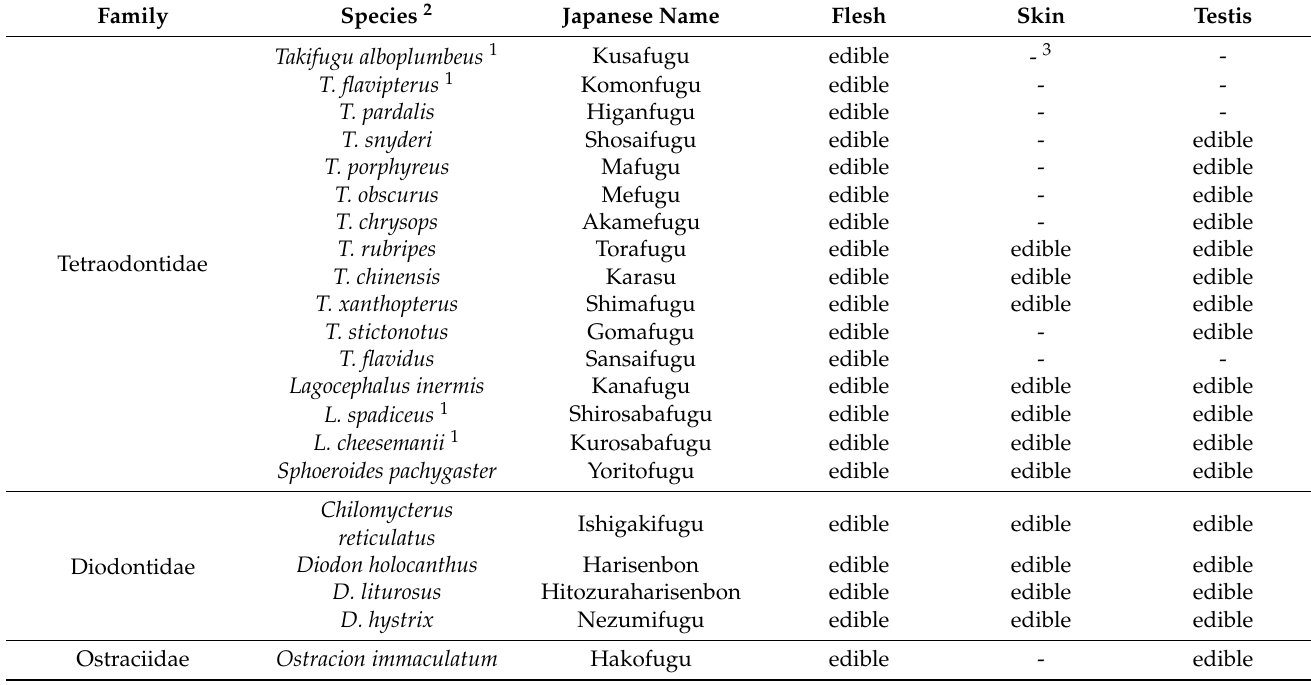
Table A1. Species and parts that can be processed to eliminate health risks 1